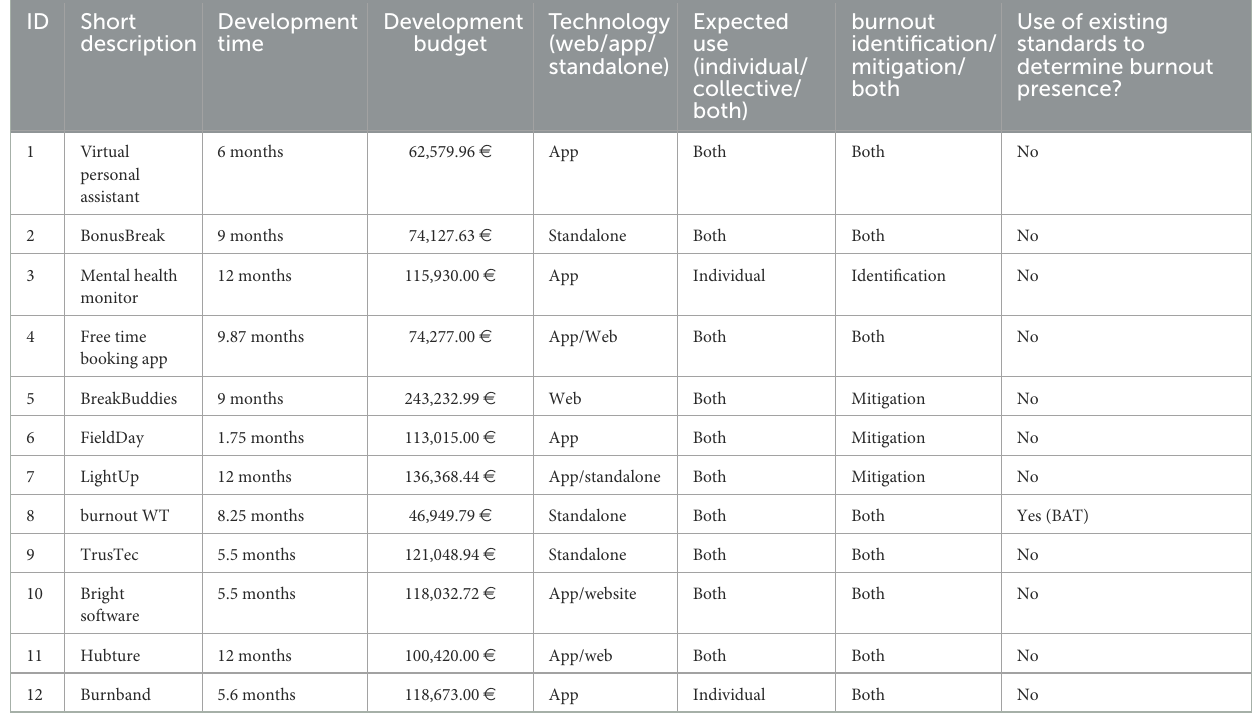
TABLE 2 Assessment of the features of the proposals—technological solutions.